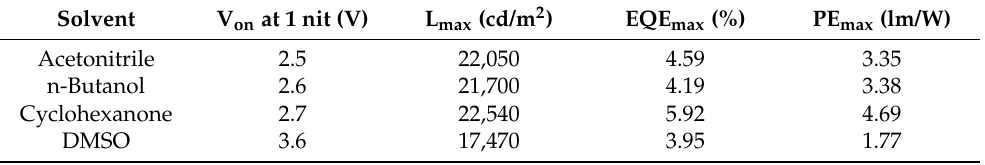
Table 2. QD-EL device performances using PMA with various